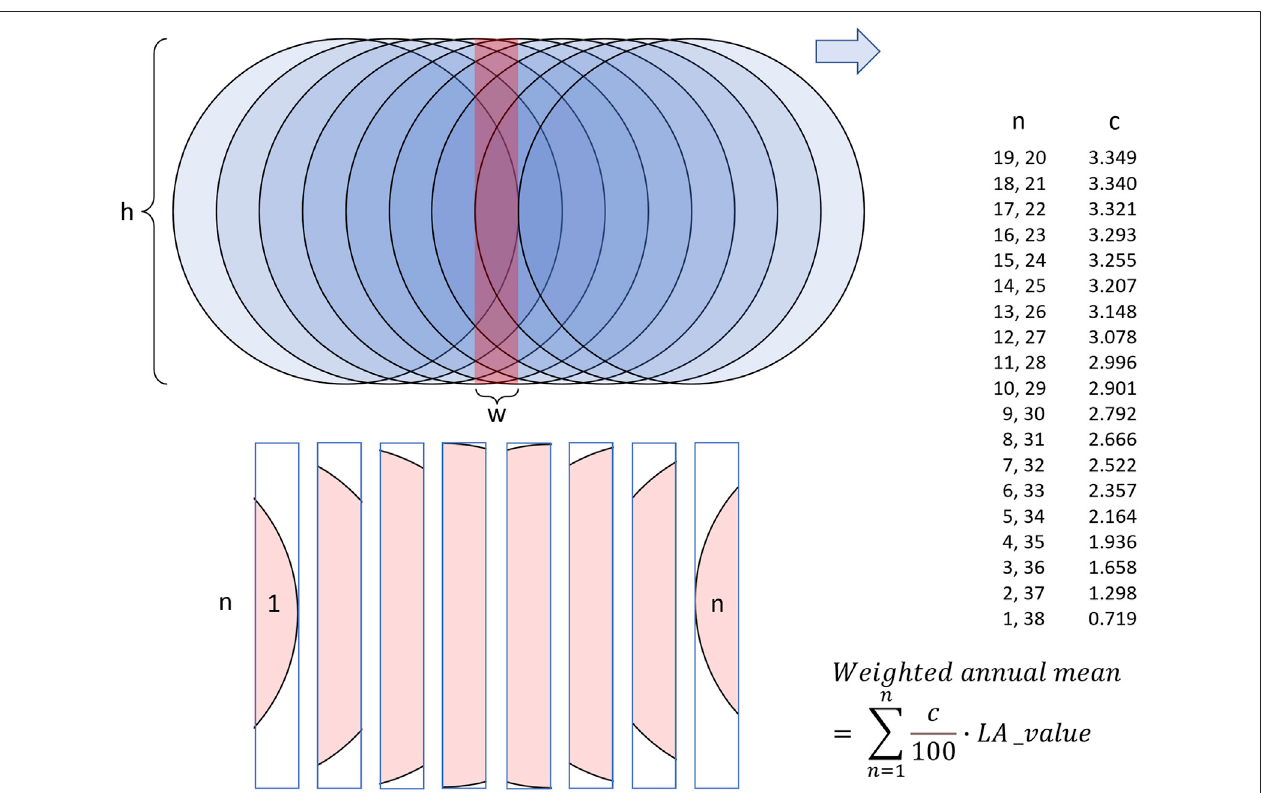
FIGURE 2 | Schematic illustration of LA-ICP-MS line scan data discretization. Blue circles denote the laser spots on the sample surface. While the laser beam moves forward (here to the right) and ablates shell material, a new data acquisition cycle starts every 1.45 µm (in the setup used in this study). For simpli fi cation of the calculations, it is assumed that measurements are instantaneously completed, while in reality, measurements are integrated over some time interval while the laser continues to travel to the right. As the laser spot diameter (h) measures 55 µm and measurements are completed at regular spatial intervals (w) of 1.45 µm, each rectangular stripe of shell (red) measuring 1.45 × 55 µm is measured 38 times (note, illustration not to scale; for simpli fi cation, only eight acquisition cycles depicted). SignalextractionofthenoisyLA-ICP-MSlinescandatashouldthusbedonewithasymmetricalmovingaverageintegrating38datapoints.Howeverduetothegeometry of the laser beam, each rectangular stripe of shell is crossed 38 times (n) by variably sized LA spot portions (pink; note, for illustration purposes n = 8). Portions near the center of the rectangular stripe of shell are measured more frequently than those near the periphery. To denoise the data properly, a 38-pt circle segment area-based weighted moving average needs to be used. Filter weights (c) for the respective LA spot (n) are listed to the right including the respective function to smooth the data. LA_val = element chemical value measured at a LA spot.